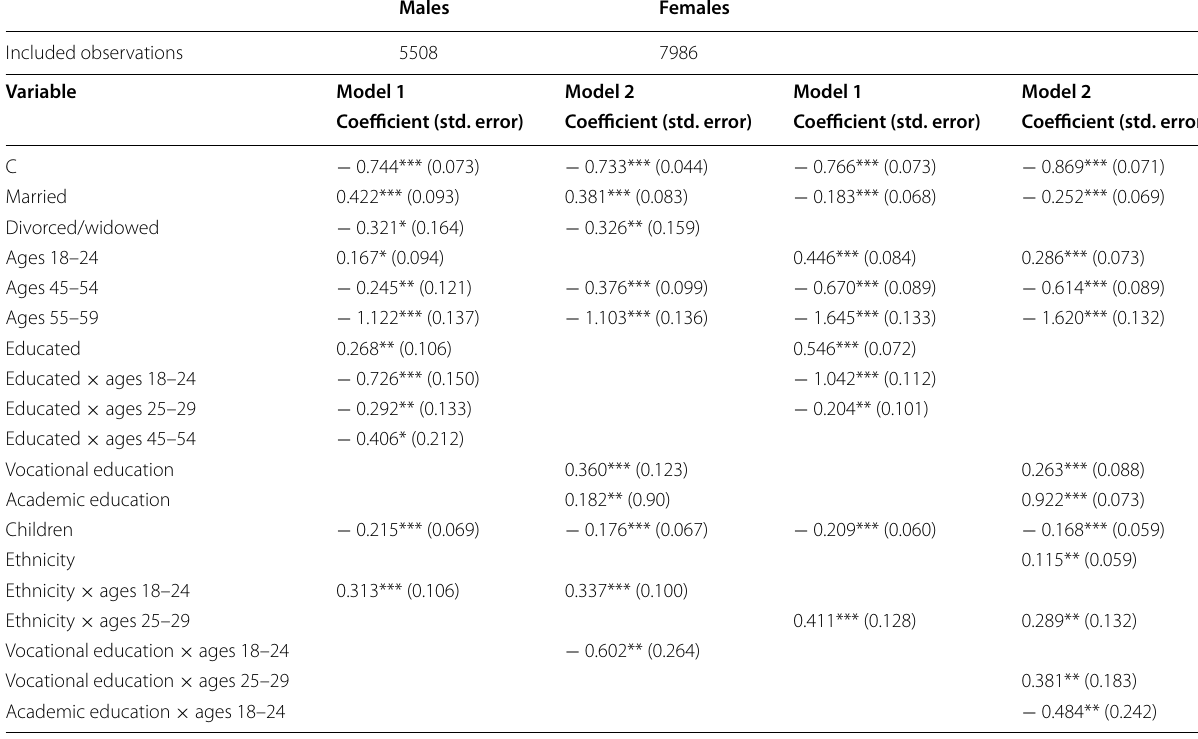
Dependent variable: being